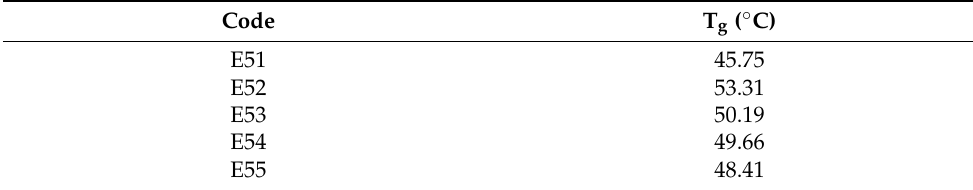
Table 2. Glass transition temperature of the nanoparticle-incorporated coatings.